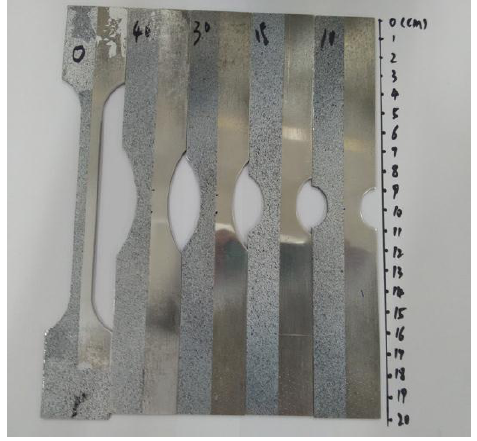
Figure 5. Sample appearances along different strain paths after surface treatment.